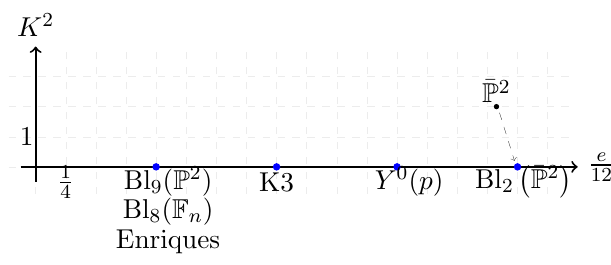
Figure 2 . Examples of moonshine surfaces at e = 12 ; 24 ; 36 ;